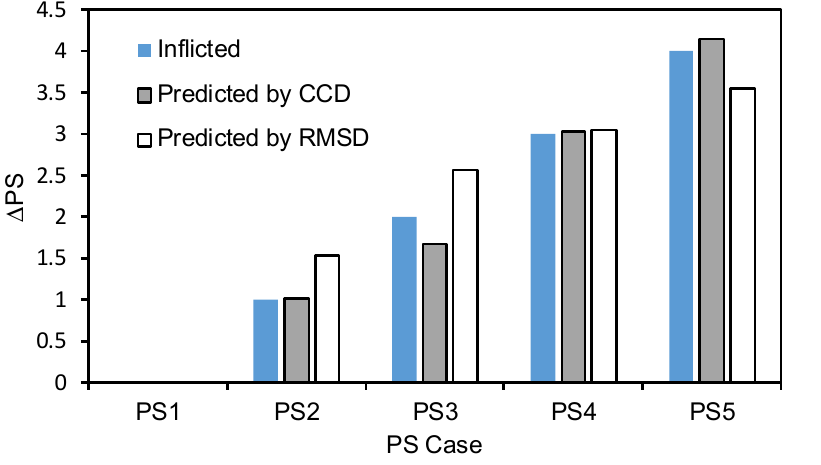
Figure 12. Prediction of PS force change using linear regression.